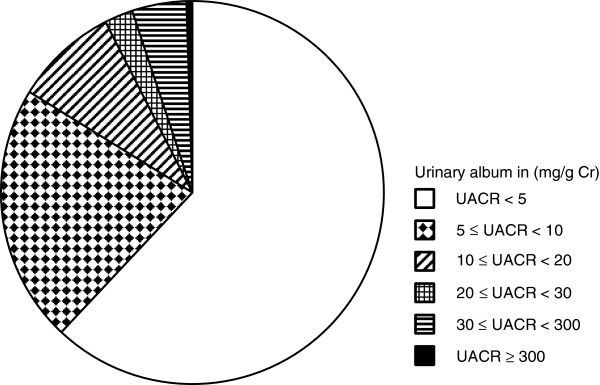
Distribution of urinary levels of albumin. Urinary albumin was detected in 7265 subjects (UACR ≥ 300 mg/g Cr, n = 41, 0.5%; 300 > UACR ≥ 30 mg/g Cr, n = 362, 4.6%; 30 > UACR ≥ 20 mg/g Cr, n =192, 2.4%; 20 > UACR ≥ 10 mg/g Cr, n = 694, 8.7%; 10 > UACR ≥ 5 mg/g Cr, n = 1737, 21.8%; UACR < 5 mg/g Cr, n = 4239, 53.2%). UACR indicates the ratio of the concentrations of urinary albumin to urinary creatinine.